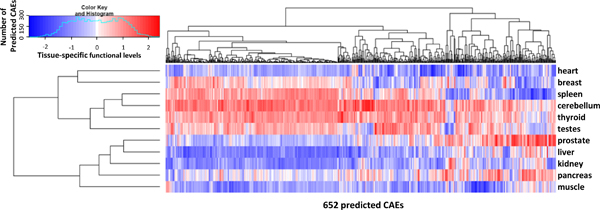
Hierarchical clustering of tissue-specific functional levels (TSFL) for all 652 predicted cis-acting RNA elements (CAEs) across all eleven tissues. TSFL greater than, lower than or equaling to 0 are represented by units with red, blue or white color. Darker red/blue indicates higher/lower functional level.